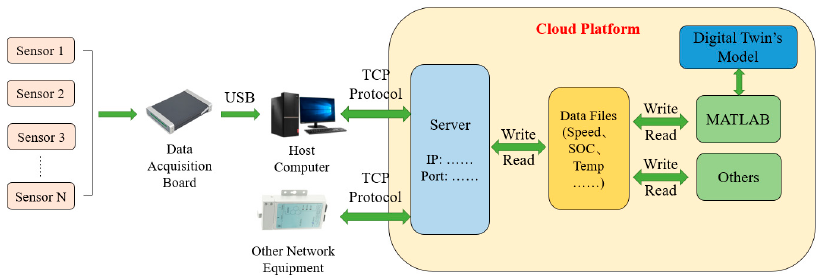
Figure 8. Cloud platform data transmission principle.